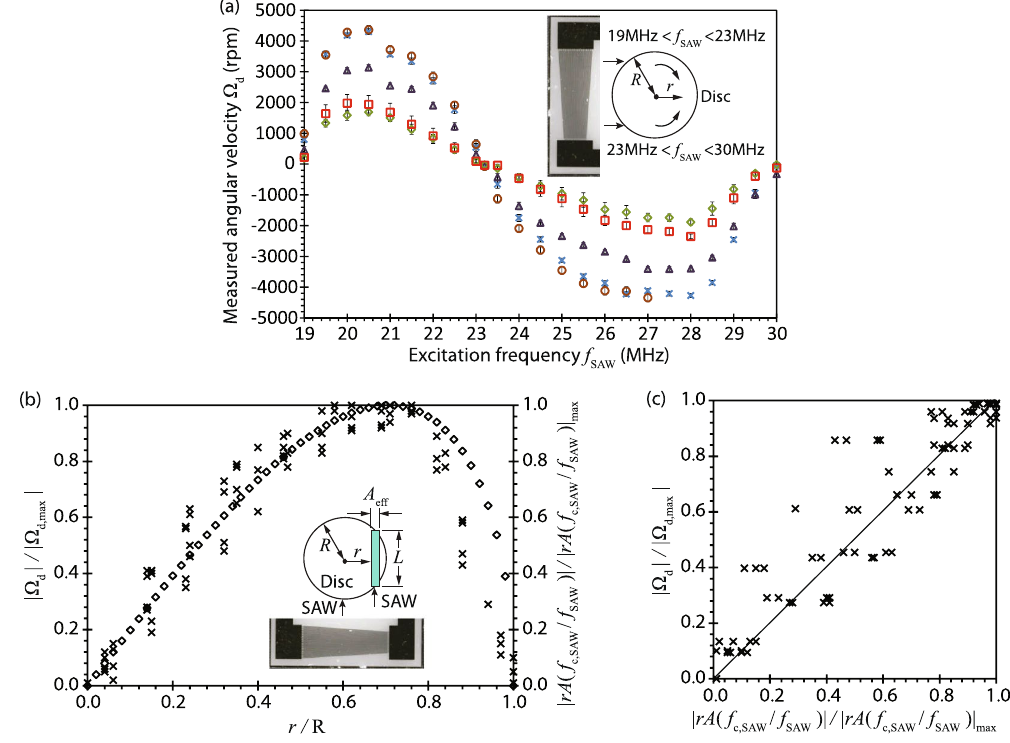
Figure 3. ( a ) Experimental measurements showing the relationship between the rotational speed of the disc Ω d and the applied frequency f SAW to the tIDTs for different electrical input powers: ( ○ ) − 1 dBm, ( × ) − 2 dBm, ( Δ ) − 4 dBm, ( □ ) − 5 dBm and ( ◇ ) − 6 dBm. The inset shows the approximate position of the disc relative to the tIDT, and indicates the frequency range f SAW which drives clockwise (19–23 MHz) and anti-clockwise (23–30 MHz) rotation. The error bars indicate the standard deviation of the data taken across triplicate measurements. ( b ) Experimentally measured ( × ) disc rotational velocity Ω d (normalised by its maximum value Ω d,max ) as a function of the radial position where the SAW is launched from the tIDT with respect to the disc’s centre r (normalised by the disc radius R ), compared to the prediction afforded by the simple theoretical model ( ◇ ). The inset shows a schematic illustrating the position of the disc with respect to the tIDT and the strip under the disc with chord length L and effective aperture A eff corresponding to the area A where the SAW is launched to give rise to acoustic streaming under the disc. ( c ) Recast of the plot in ( a ) showing the linear relationship between the disc rotational velocity Ω d and the theoretical prediction rA ( f c,SAW / f SAW